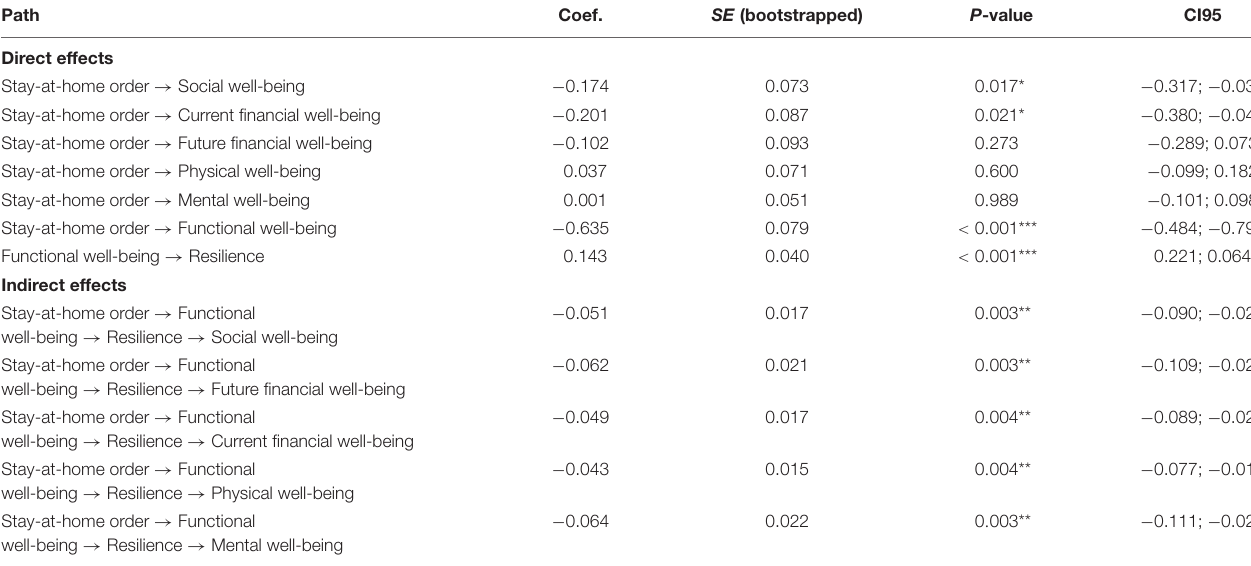
TABLE 4 | Path coefficients for direct and indirect effects of stay-at-home orders on resilience and well-being components. Path Coef. SE (bootstrapped) P -value